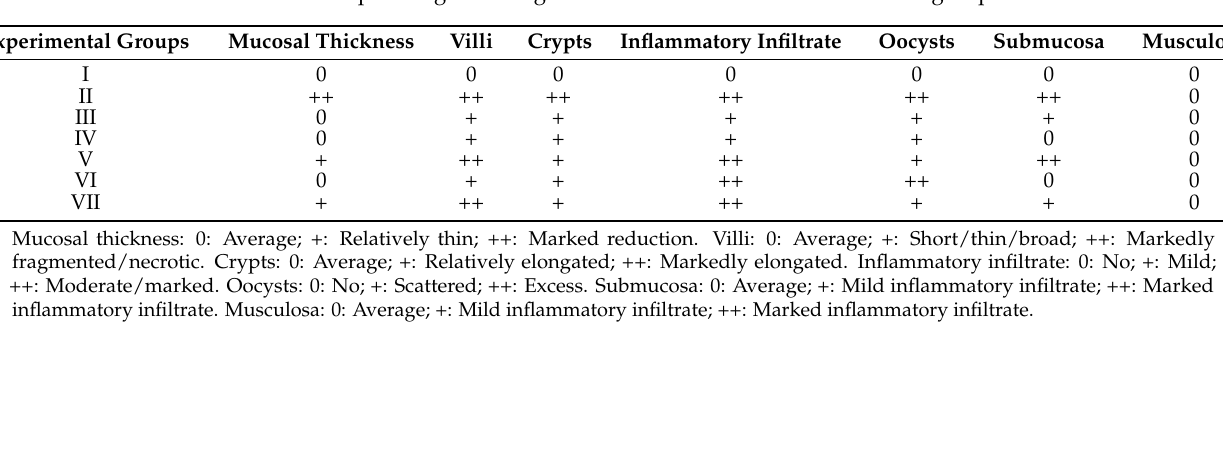
Table 3. Histopathological changes in the intestinal sections of different